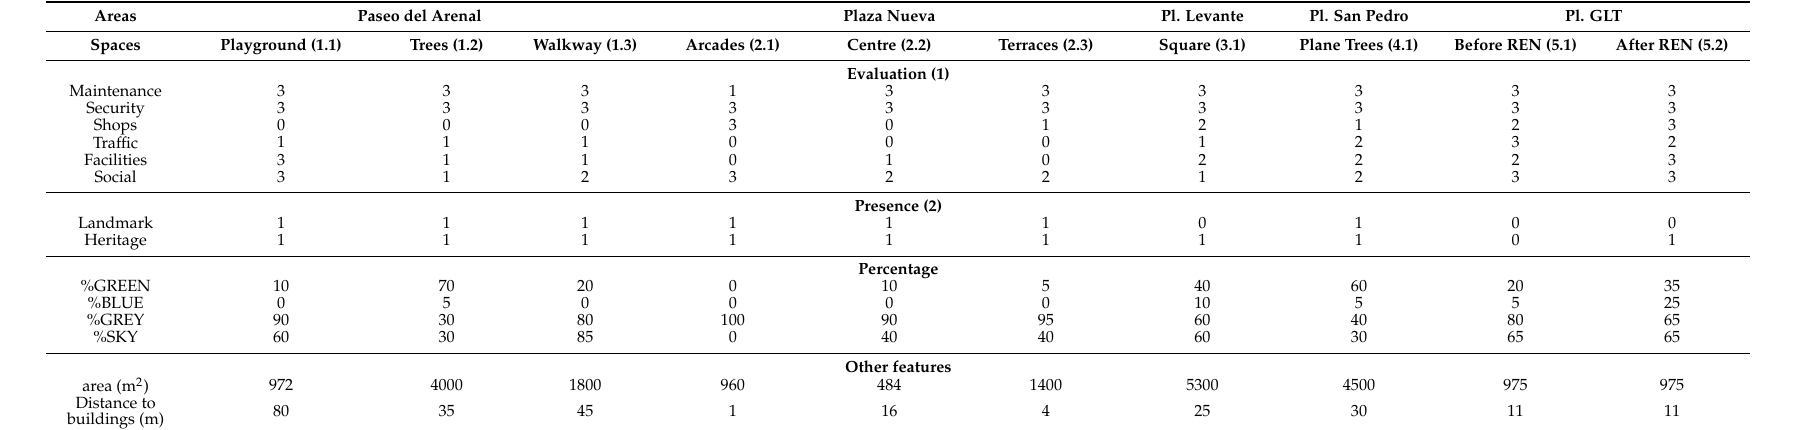
Table 1. Description of the ten analysis units